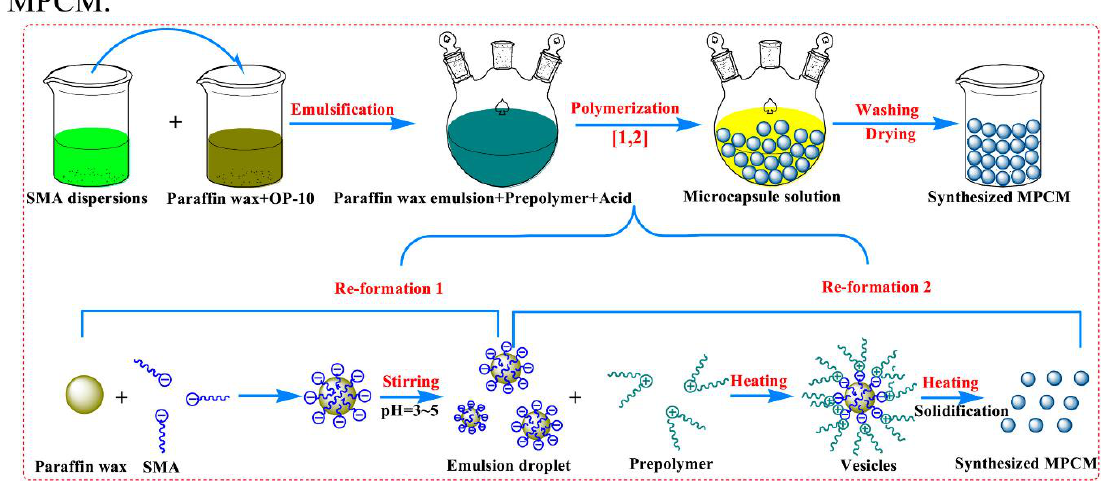
Figure 9. Representation of the synthesize of MPCM [50].